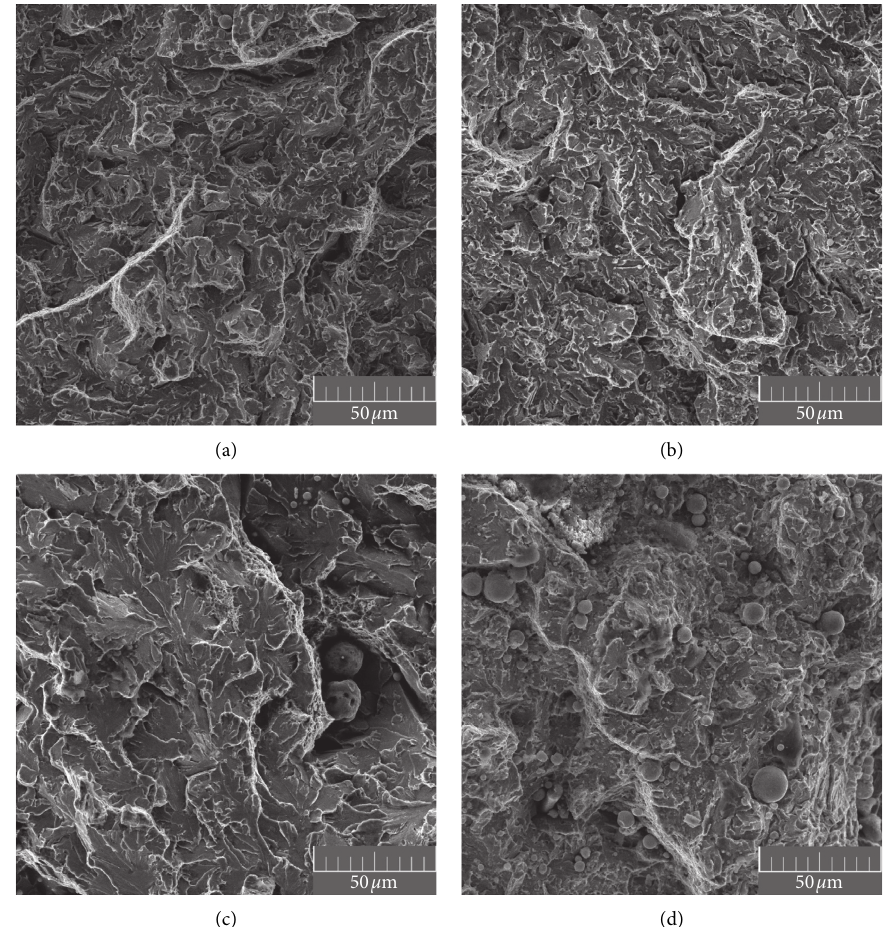
Figure 9: SEM micrographs of fracture surfaces of (a) CHT specimens and CT specimens treated for (b) 2h, (c) 12h, and (d)